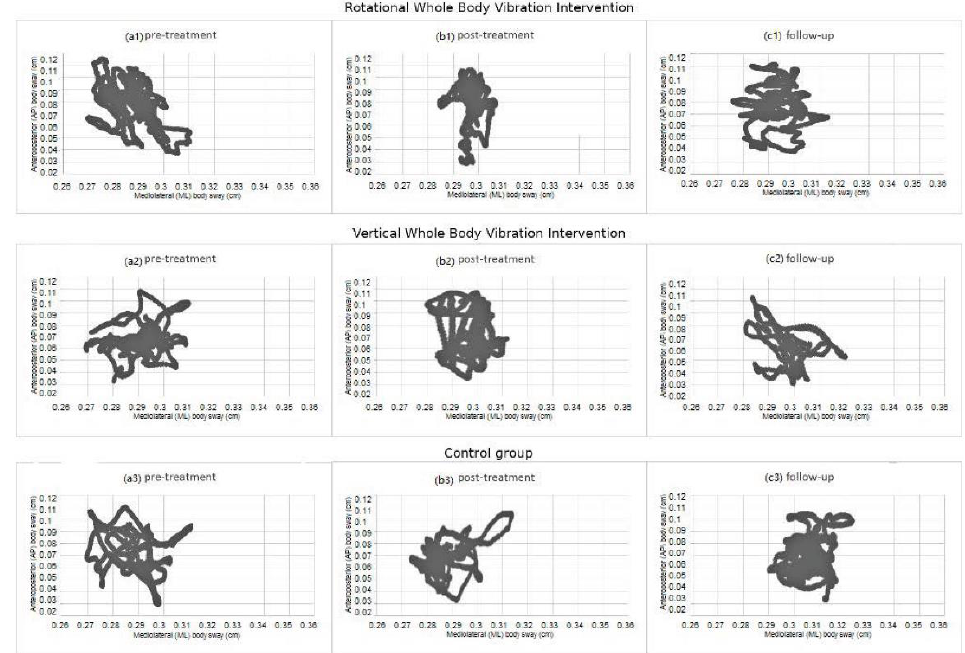
Figure 2. Mean of mediolateral body sway (axis X) and mean of anteroposterior body sway (axis Y) in pretreatment, post-treatment, and follow-up for the intervention groups and for the control group.